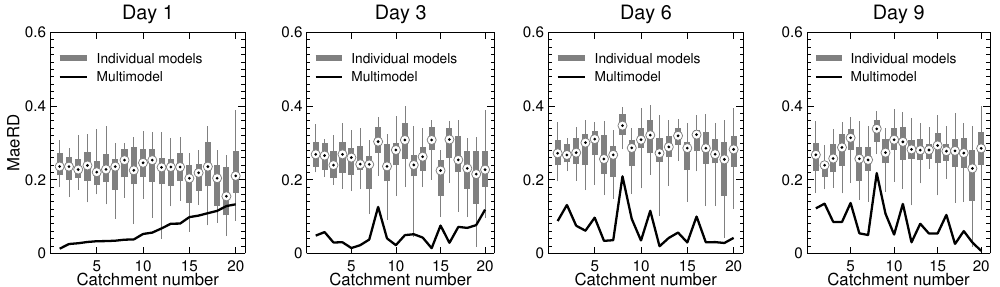
Figure 11. Comparison of the deviation from perfect reliability of EnKF individual models and the EnKF multimodel, both using MEPS forcing sorted by increasing EnKF multimodel MaeRD for the first day (system D vs. H).